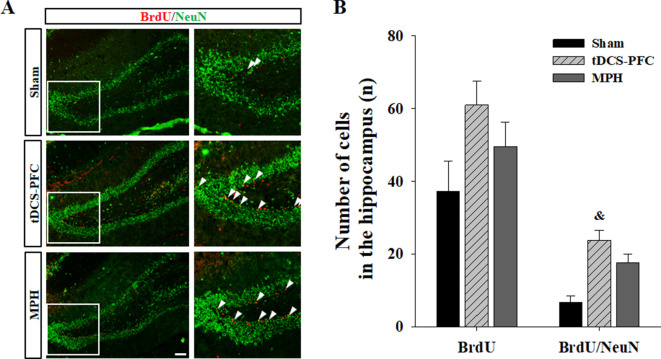
Effect of HD-tDCS application over the prefrontal cortex on hippocampal neurogenesis in our rat model of ADHD.(A, B) Photomicrograph and histogram showing the mean number of BrdU - and NeuN-positive cells in the dentate gyrus of the hippocampus. The number of BrdU/NeuN double-positive cells was significantly higher in the tDCS-PFC group compared to the sham animals. Data are presented as the mean ± SEM. &p<0.05 vs. sham. Scale bar = 100 µm.Figure 5—source data 1.Source files for quantification of BrdU- and BrdU/NeuN-double-positive cells.This file contains all source data for BrdU- and BrdU/NeuN-double-positive cells analysis shown in Figure 5.